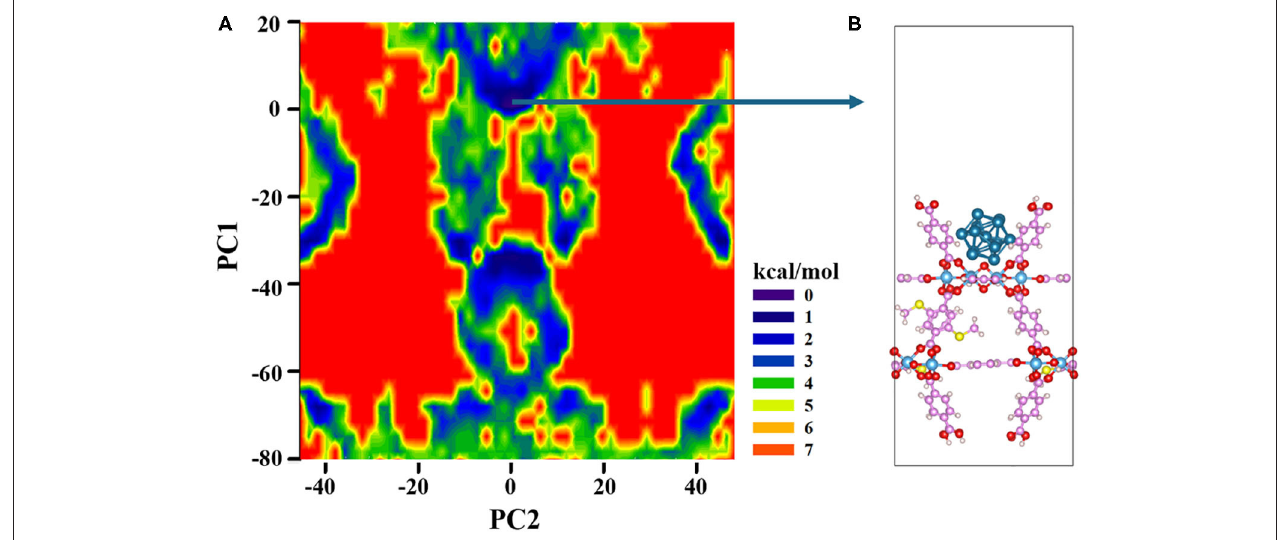
FIGURE 1 | (A) Free energy landscapes based on PCA method. (B) Snapshot extracted from the MC trajectory for the Pt 13 /20%-MIL-125-(SCH 3 ) 2 (001) composite